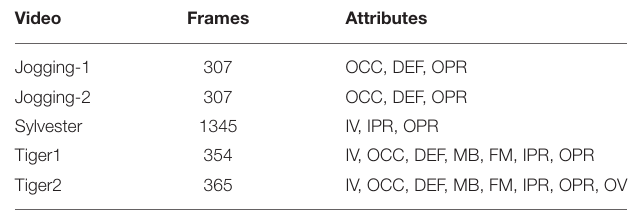
difference frame, we execute 15 iterations of Equation